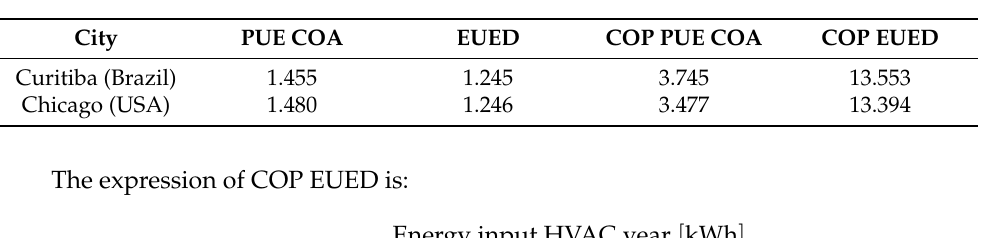
Table 9. Comparison of PUE COA, EUED, COP PUE COA and COP